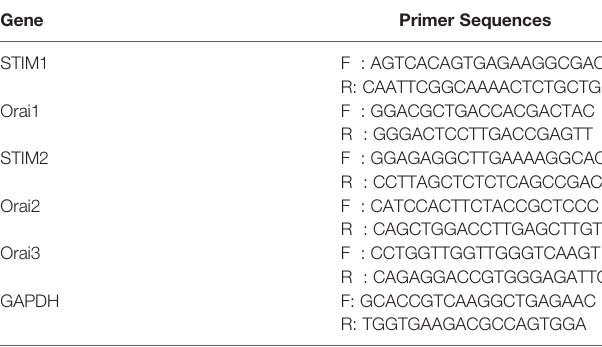
TABLE 1 | Sequences of primers for RT-PCR.